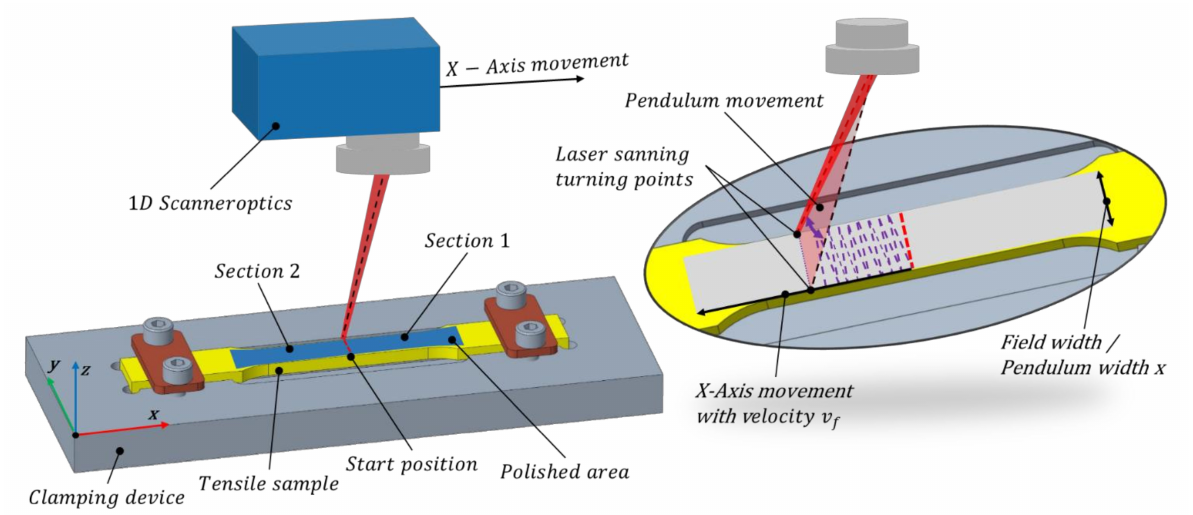
Figure 5. Schematic illustration of the orientation of the tensile specimens and used clamping device. Laser beam guidance by scanner one dimensional pendulum beam deflection and superimposed axis movement.